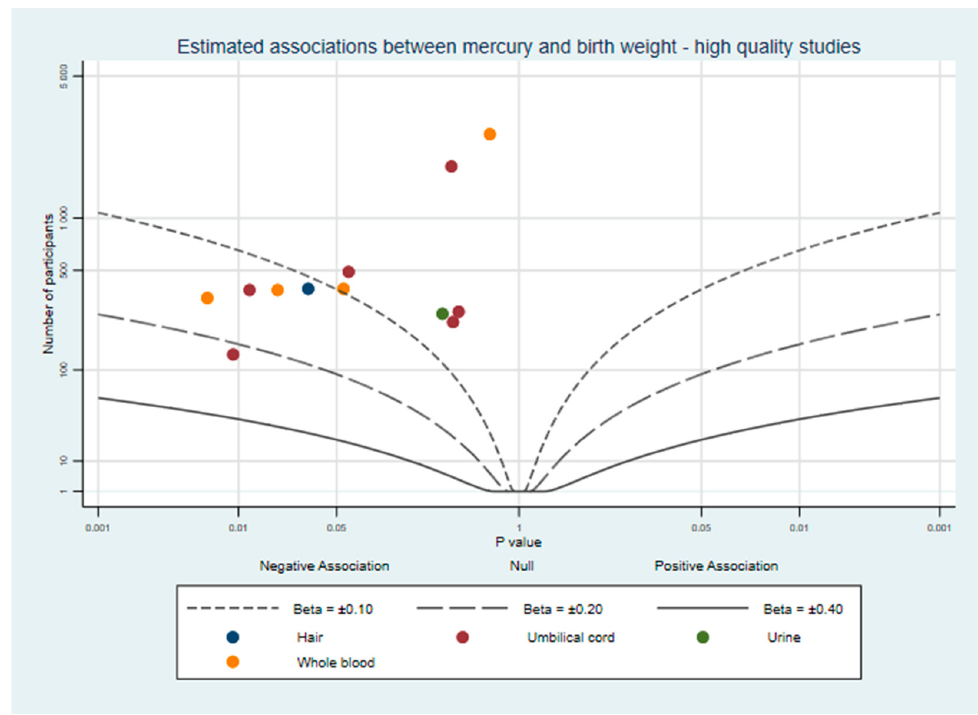
Figure 3. Albatross plot of the estimated effect of mercury exposure on birth weight, from studies which adjusted for maternal socio-economic status or education, fish or fatty acid intake, and maternal smoking status.